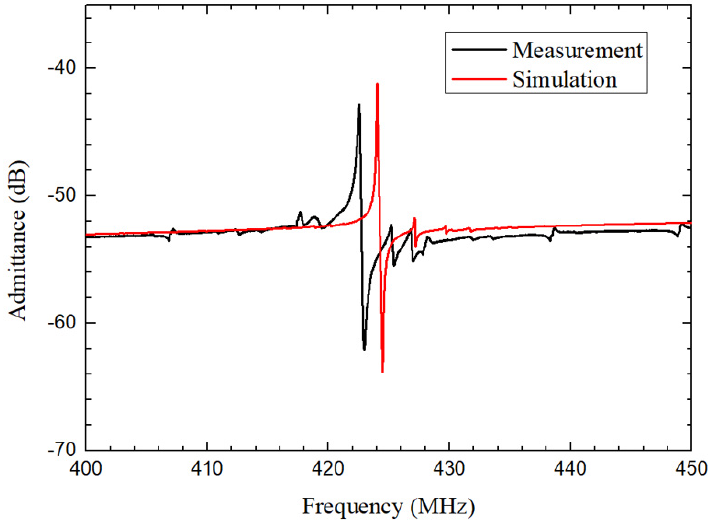
Figure 7. Measured and simulated admittance responses of the QSAW resonator with λ of 10.4 µ m in a frequency range from 400 MHz to 450